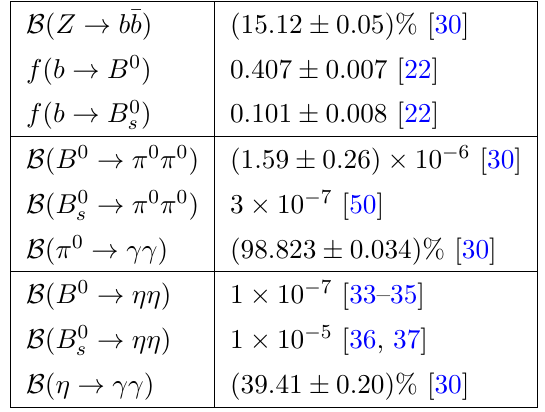
Table 3 . Numerical values used to estimate the yields of B 0 The notation f ( b → B 0 ) represents the fraction of B 0 ( s ) and the symbol B denotes the decay branching